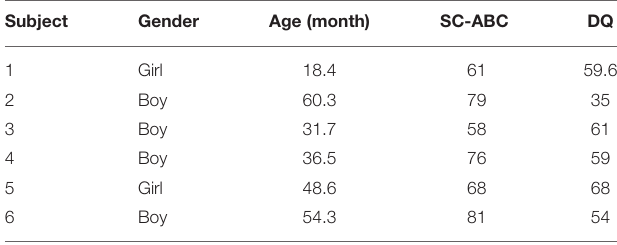
TABLE 1 | General clinical data of